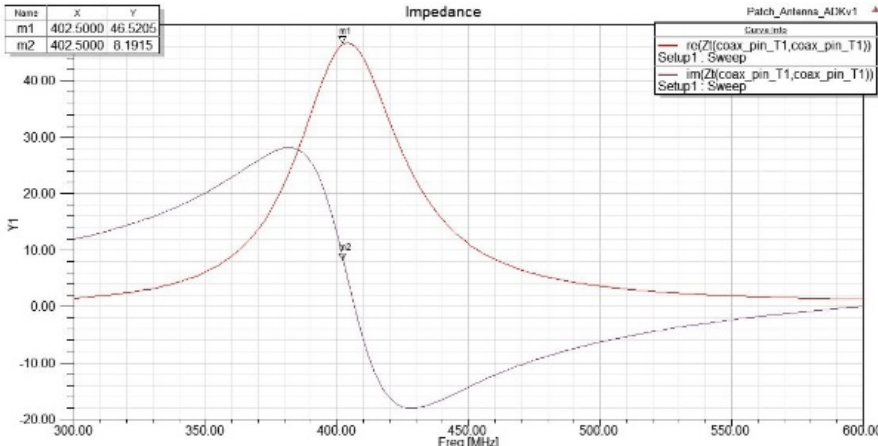
pancreas model. creas model.